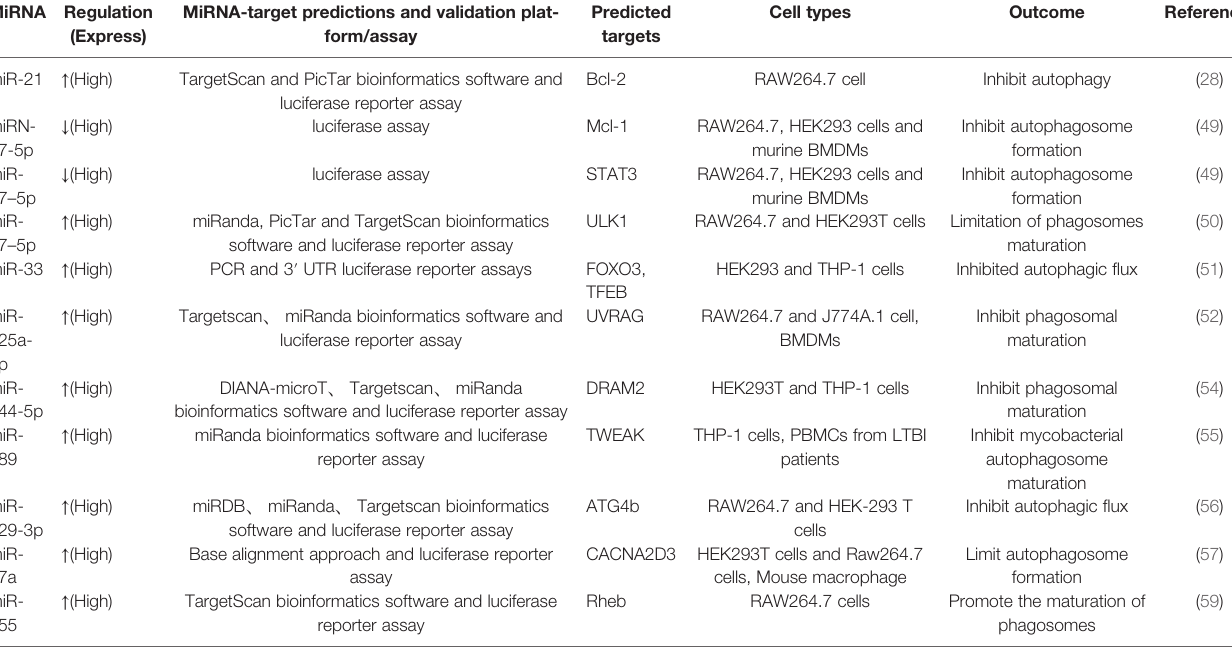
BMDM, bone marrow-derived macrophages; MDM, monocyte-derived macrophages; PBMC: PBMC, peripheral blood mononuclear cells. ↑ , upregulation; ↓ , Downregulation.